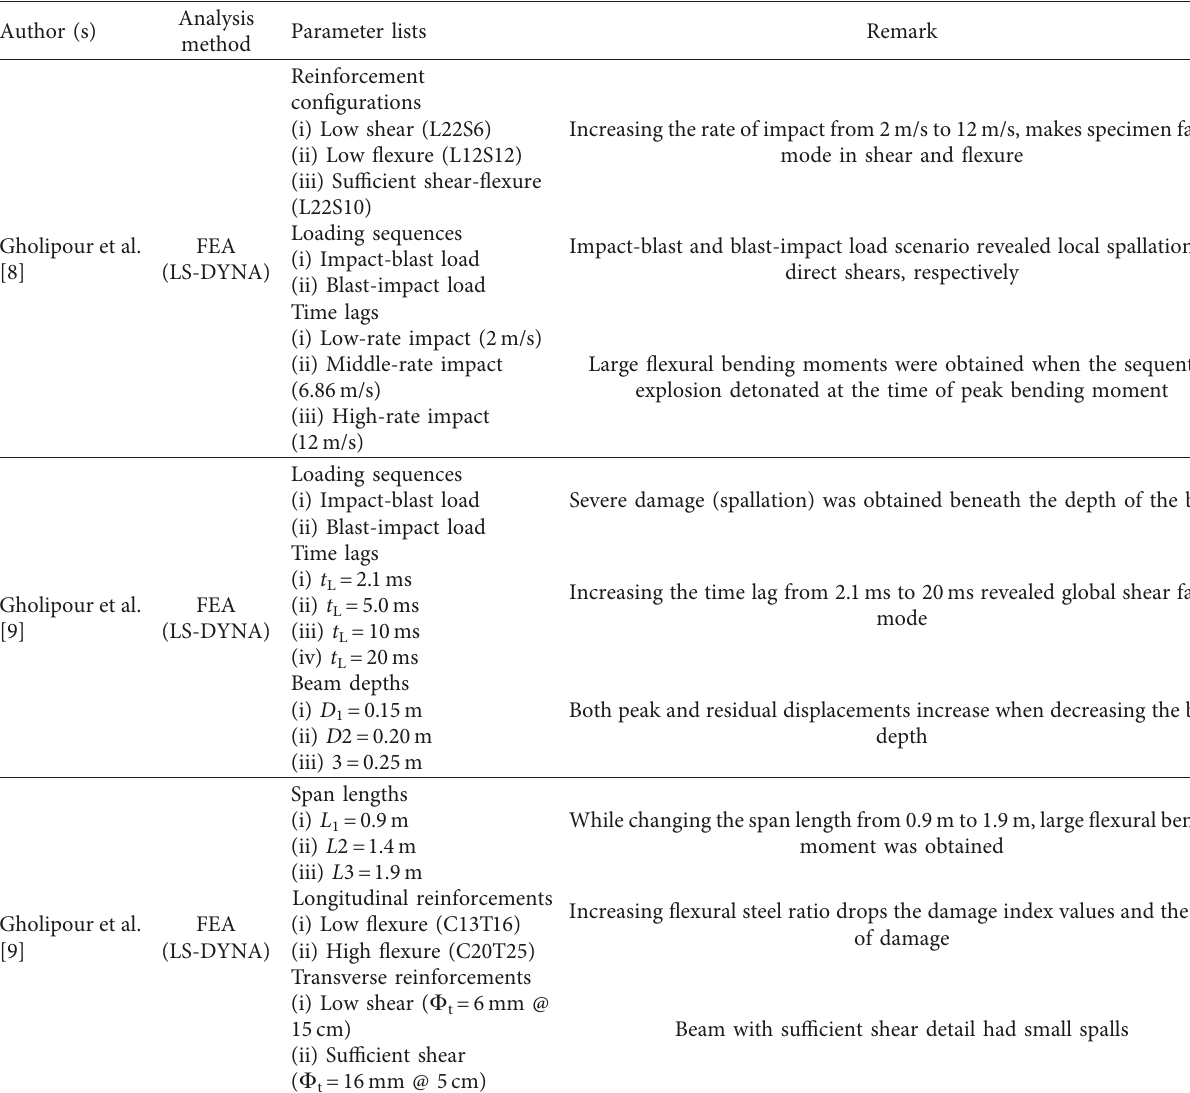
Table 2: Summary of different parameters and respective effects on RC beams subjected to combined blast and impact